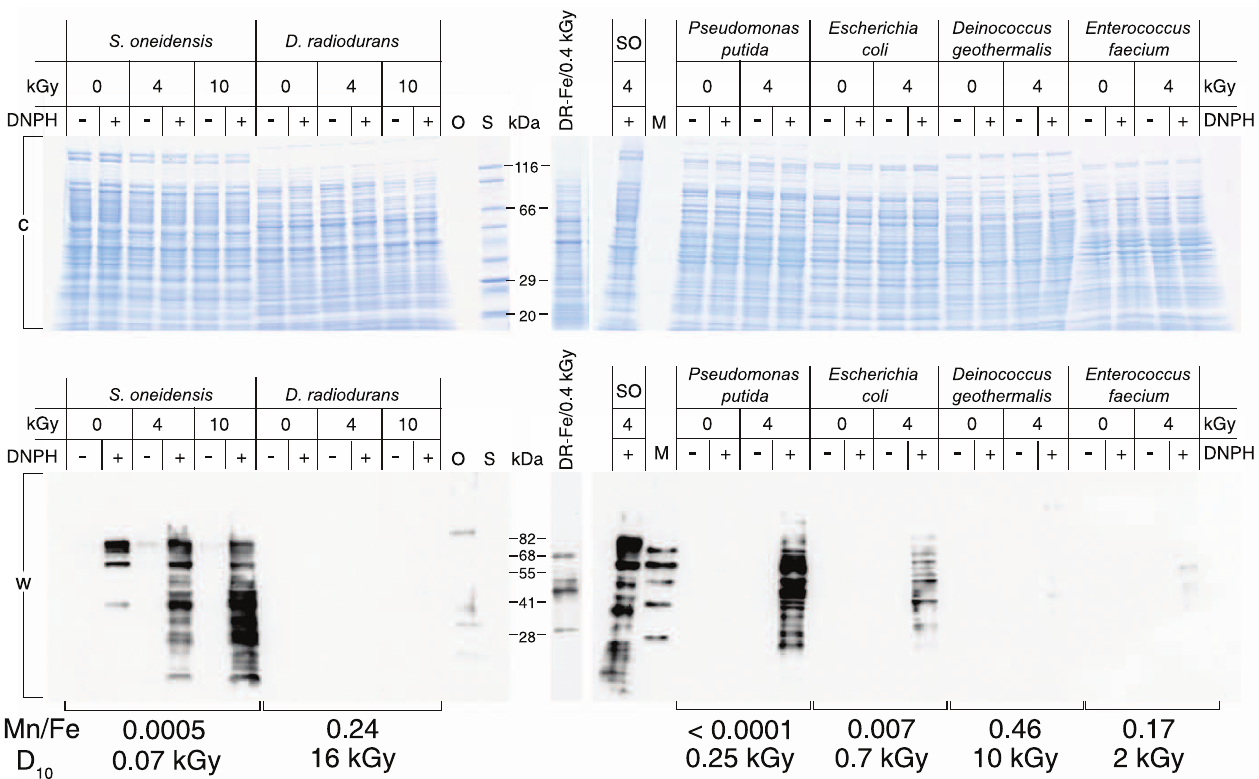
Figure 3. In Vivo IR-Induced Oxidative Protein Damage Samples were treated ( þ ) or not treated ( (cid:3) ) with DNPH. For the Western blot (W) and for the Coomassie-stained polyacrylamide denaturing gel (C), 20- l g protein samples were loaded per lane. DR/Fe/0.4 kGy indicates that the D. radiodurans (non-irradiated) cell extract was adjusted to 500 l M FeCl 2 and exposed to 0.4 kGy in vitro. Values for intracellular Mn/Fe concentration ratios and D 10 at the bottom of the figure, as reported previously [1]. M, mixture of artificial IgG-binding protein standards; O, oxidized protein standards; S, wide-range protein standards; SO, S. oneidensis